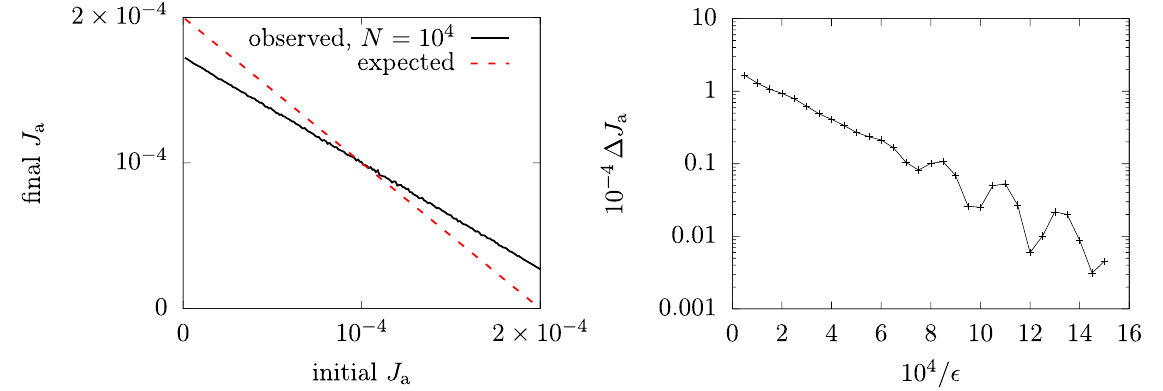
− J , black line) and expected, ( J , red, dashed) final value of the invariant as a function of J a ; f i b a ; i value is associated a uniform distribution of angles in ½ 0 ; 2 π (cid:3) . Right: amplitude of the a ; i 0 (close to the fixed-point position) as a function of 1 = ϵ . The map (60) has been a ; i ¼ 2 . 602 , ω 2 . 5 , ω 2 . 7 , and a set of initial conditions with J x ¼ y ; i ¼ y ; f ¼